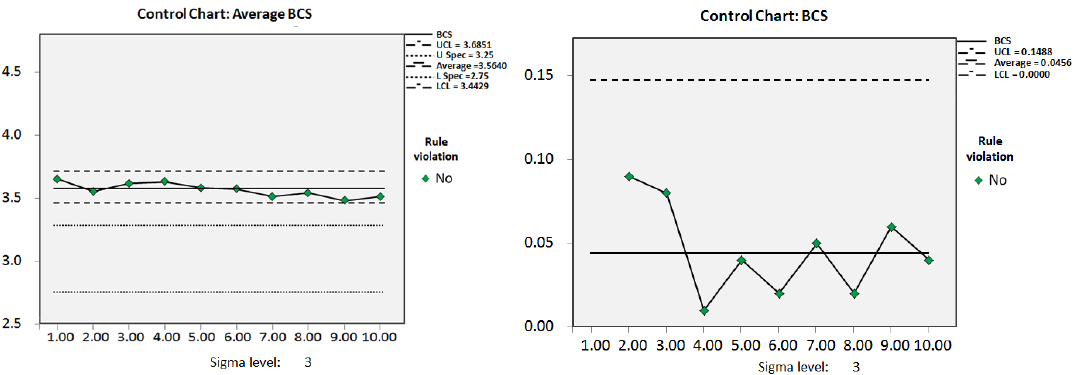
Figure 3. Individual moving range control chart for monitoring average BCS of the herds. Left : average BCS; Right : BCS changes ( Δ BCS). BCS: body condition score; UCL: upper control limit; U Spec: upper specification; L Spec: lower specification; LCL: lower control limit.